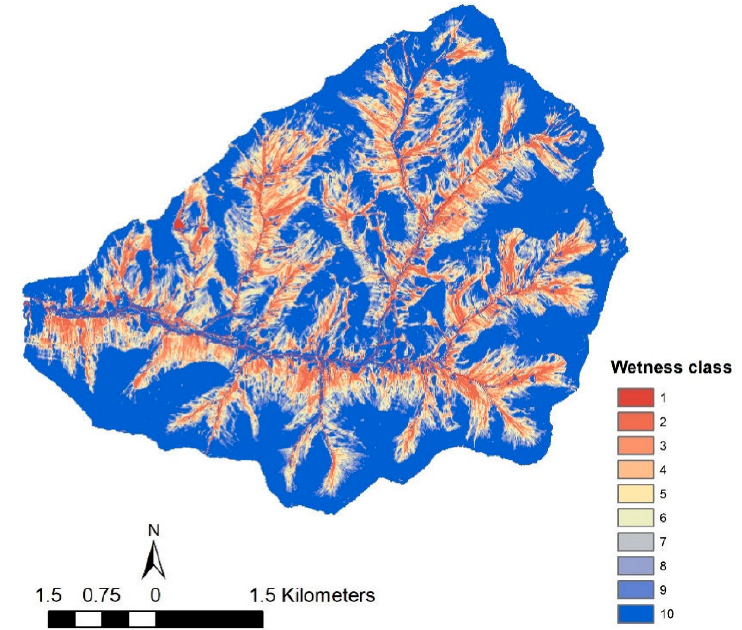
Figure 1. Town Brook watershed: wetness classes based on the topographic wetness index.